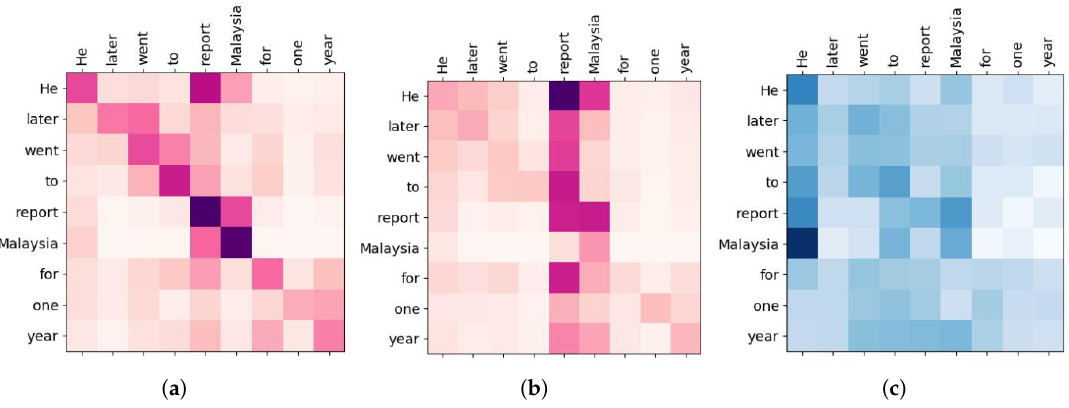
Figure 7. Attention matrix visualization: ( a ) weights in BERT Encoding Unit (Entity BERT), ( b ) weights in BERT Encoding Unit (EBAGCN), ( c ) weights in Attention Guided Layer